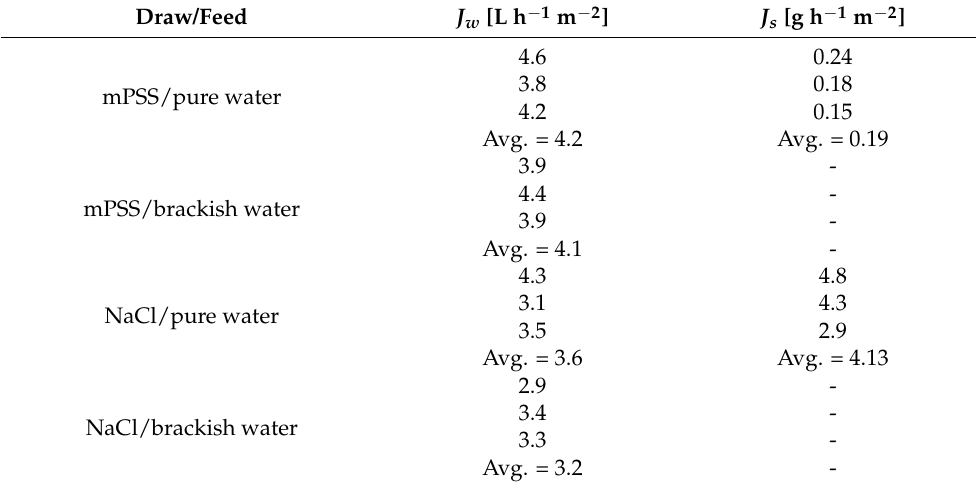
Table 1. Summary of the FO performance of CTA membrane operated in AL-FS orientation, using 50 ms/cm mPSS and NaCl as draw solutions and pure water and brackish water as feed solutions.